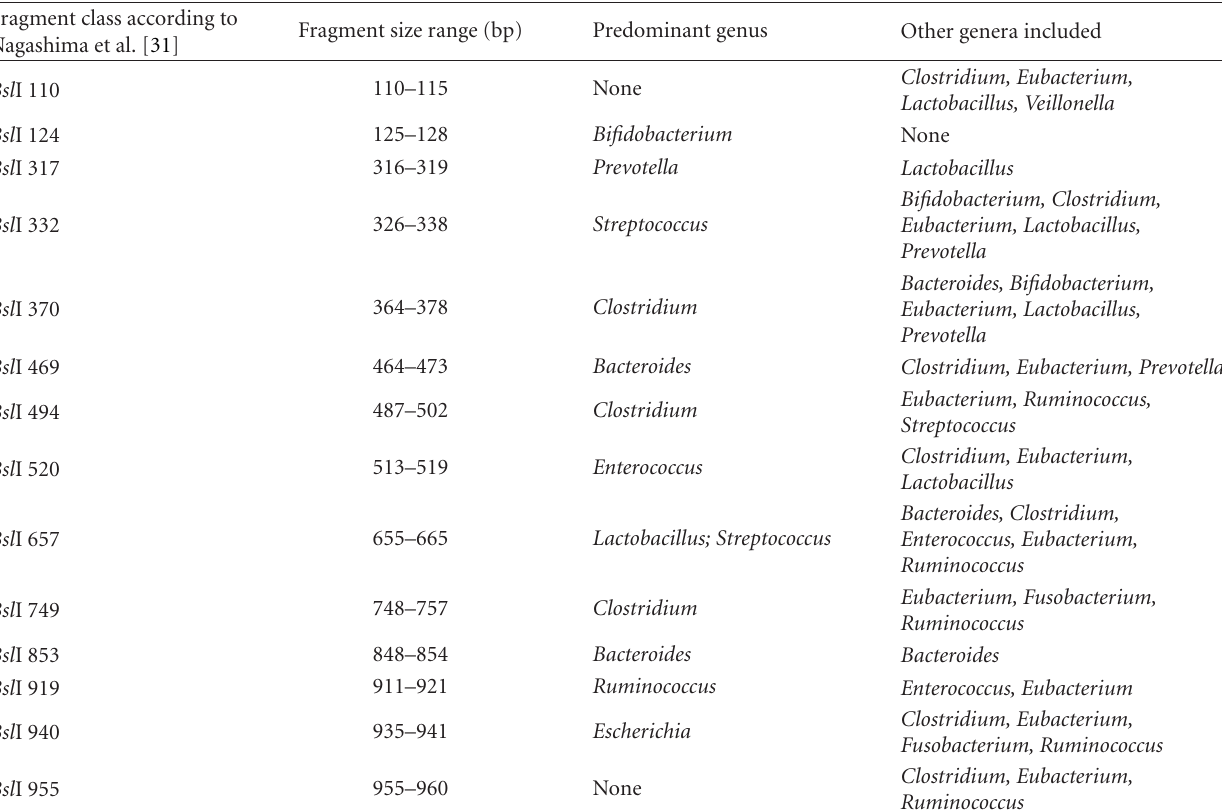
Table 2: Assignment of T-RFLP fragment size classes to bacterial taxa based on data of Nagashima et al. [31]. Fragment class according to Nagashima et al.